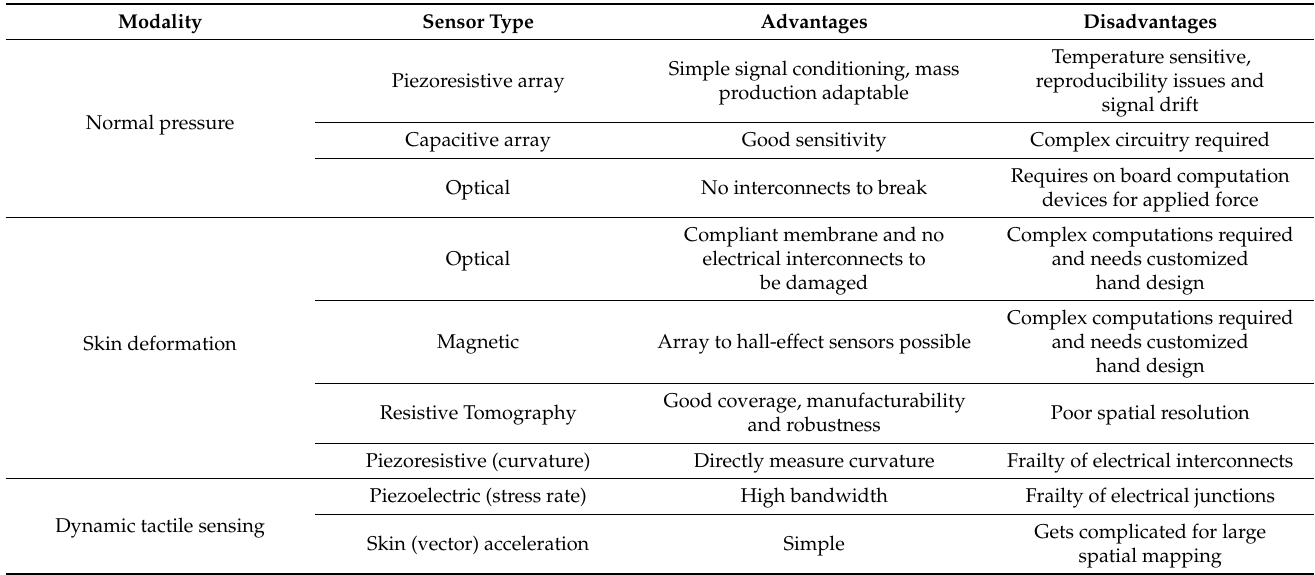
Table 1. Classical modes (excluding MEMS) of tactile sensors. Reprinted/adapted with permission from Ref. [25]. Copyright 2013,